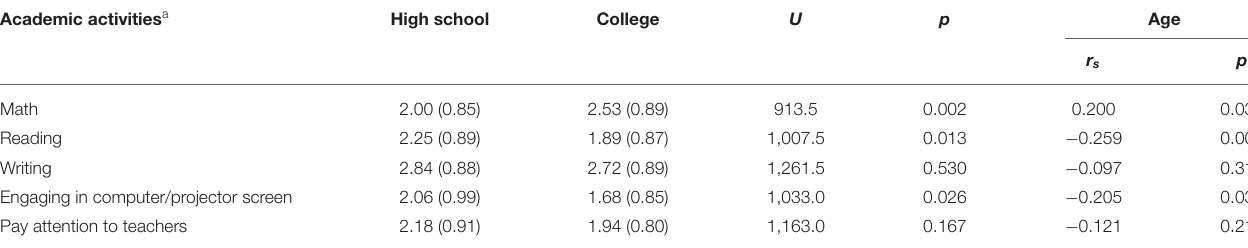
TABLE 2 | Perception of difficulty in performing academic tasks after a concussion as a function of level of schooling and age. Academic activities a